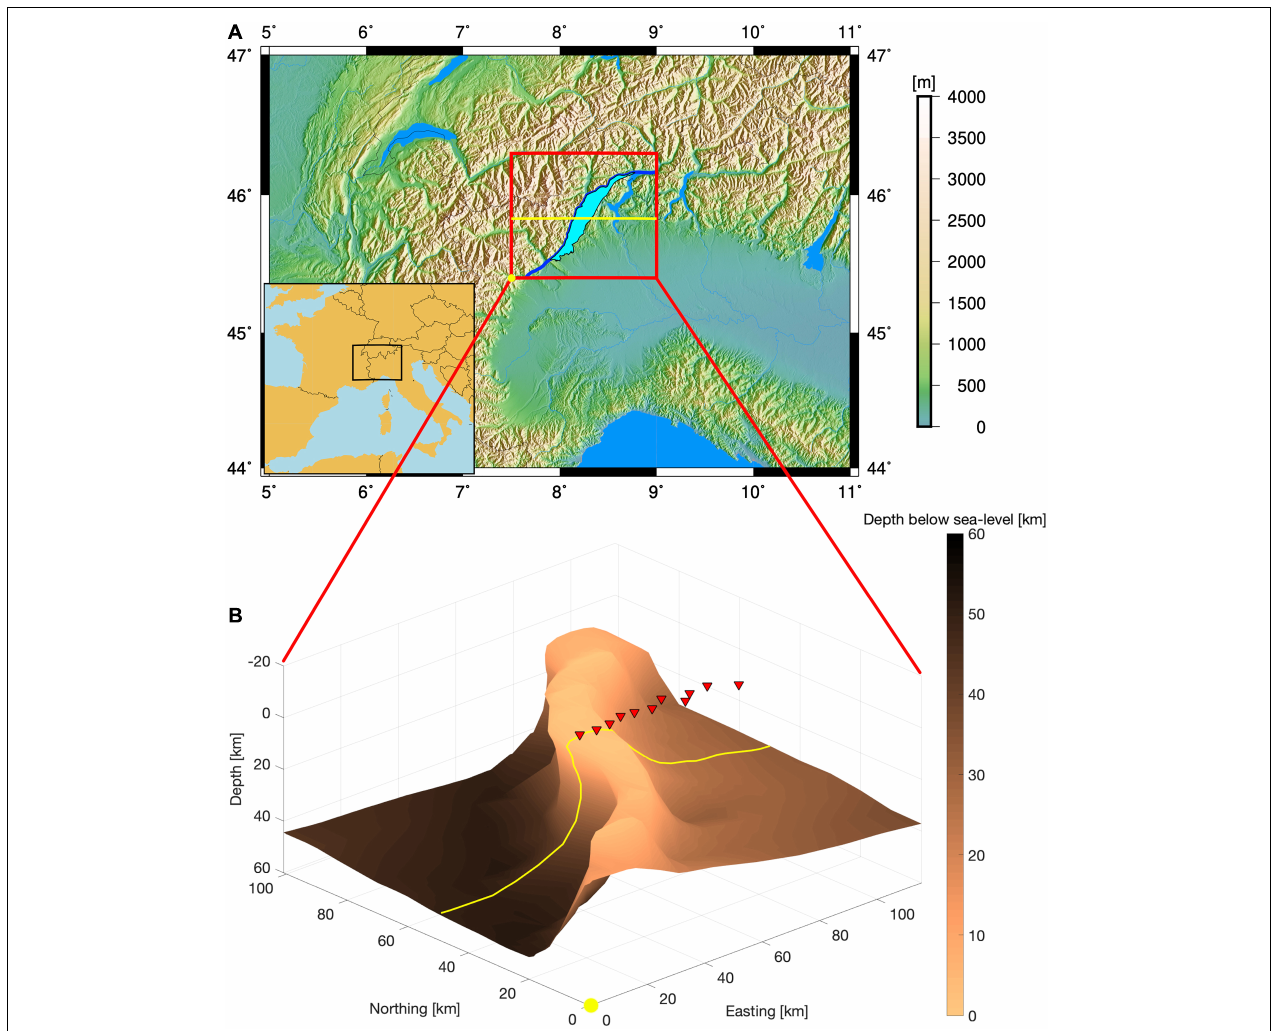
FIGURE 1 | Study area and earlier 3D IGB density model. (A) View of the study area. The 2D cross-section investigated in this study, along the 2D West-East IvreaArray seismic profile (red triangles in panel b), is highlighted by a yellow line. This target profile extends across the IVZ (cyan shape), delimited on the West by the Insubric Line (blue line). The yellow circle is the origin of the km-coordinate system used in this study and the subsequent figures (7.5 ◦ E, 45.4 ◦ N). The inset show the overview map’s location in Europe. (B) Perspective view of the IGB 3D density model interface, constrained by gravity data modelling in an earlier study (Scarponi et al.,